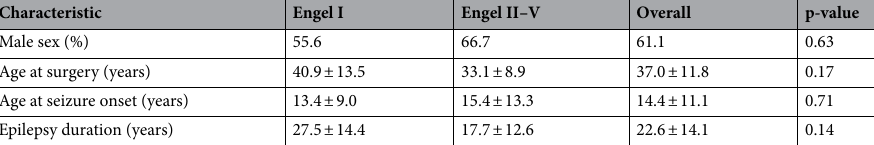
Table 2. Patients characteristics and clinical outcomes. Plus-minus values are mean ± SD. Epilepsy duration was the duration from the onset of seizures to epilepsy surgery. Between the well-controlled and residual groups, sex was compared using the chi-square test, and other were compared using the student’s t-test.